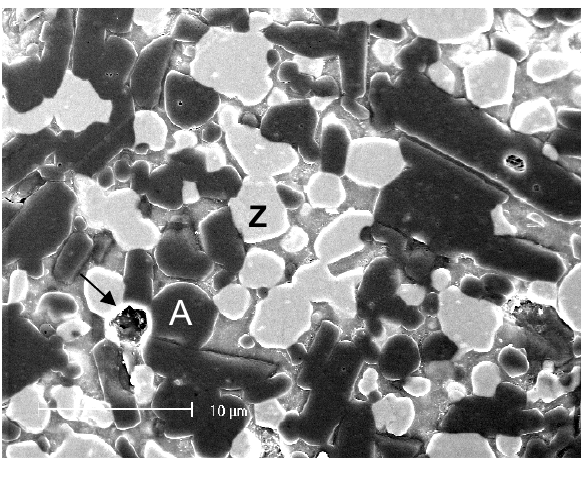
Figure 7. Microstructure of zirconia-toughened alumina slip-cast ceramic. A: alumina grains, Z: zirconia grains, Arrow indicates